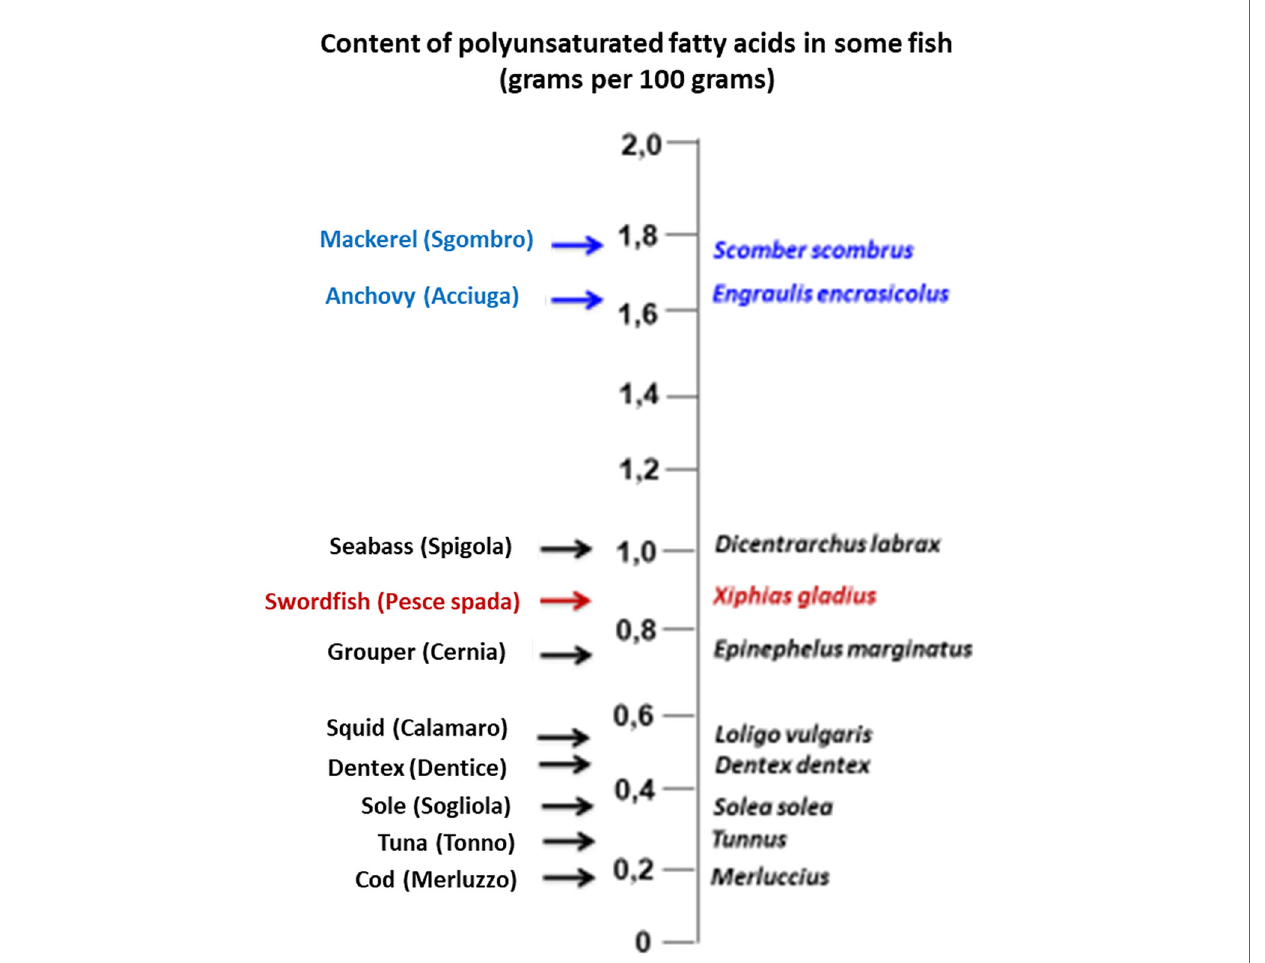
FIGURE 1 | Content of polyunsaturated fatty acids in illustrative species of fi sh. Oily fi sh (which are referred to as “ pesce azzurro ” [ “ azure fi sh ” ] in Italy) are typed in blue, while sword fi sh (the top predator fi sh that is mentioned more frequently in our review) is typed in